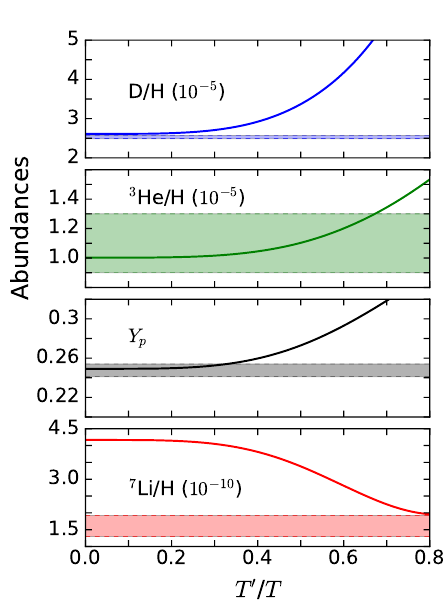
Figure 5: BBN model prediction for the relative abun- dances of D, 3 He, 4 He (mass fraction, Y p ) and 7 Li as a function of early universe temperatures ratio between the dark sector temperatures and visible matter temperature, T (cid:48) / T . The calculations were done assuming that the num- ber of dark sectors are N DM = 5. The bands represent uncertainties in the observations